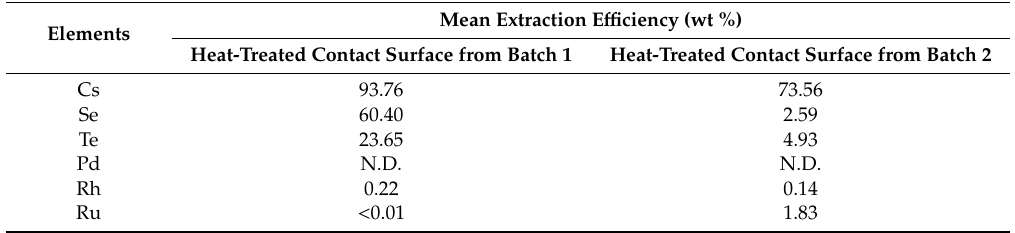
Table 5. The extraction e ffi ciency of the elements in di ff erent liquid metal